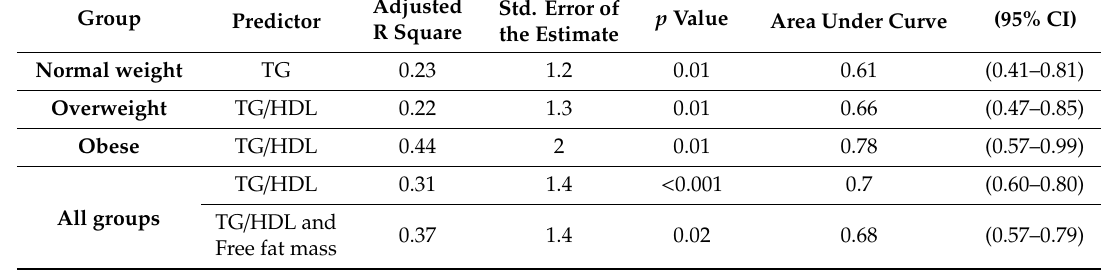
Table 3. Variables explaining HOMA-IR by generalized linear model.